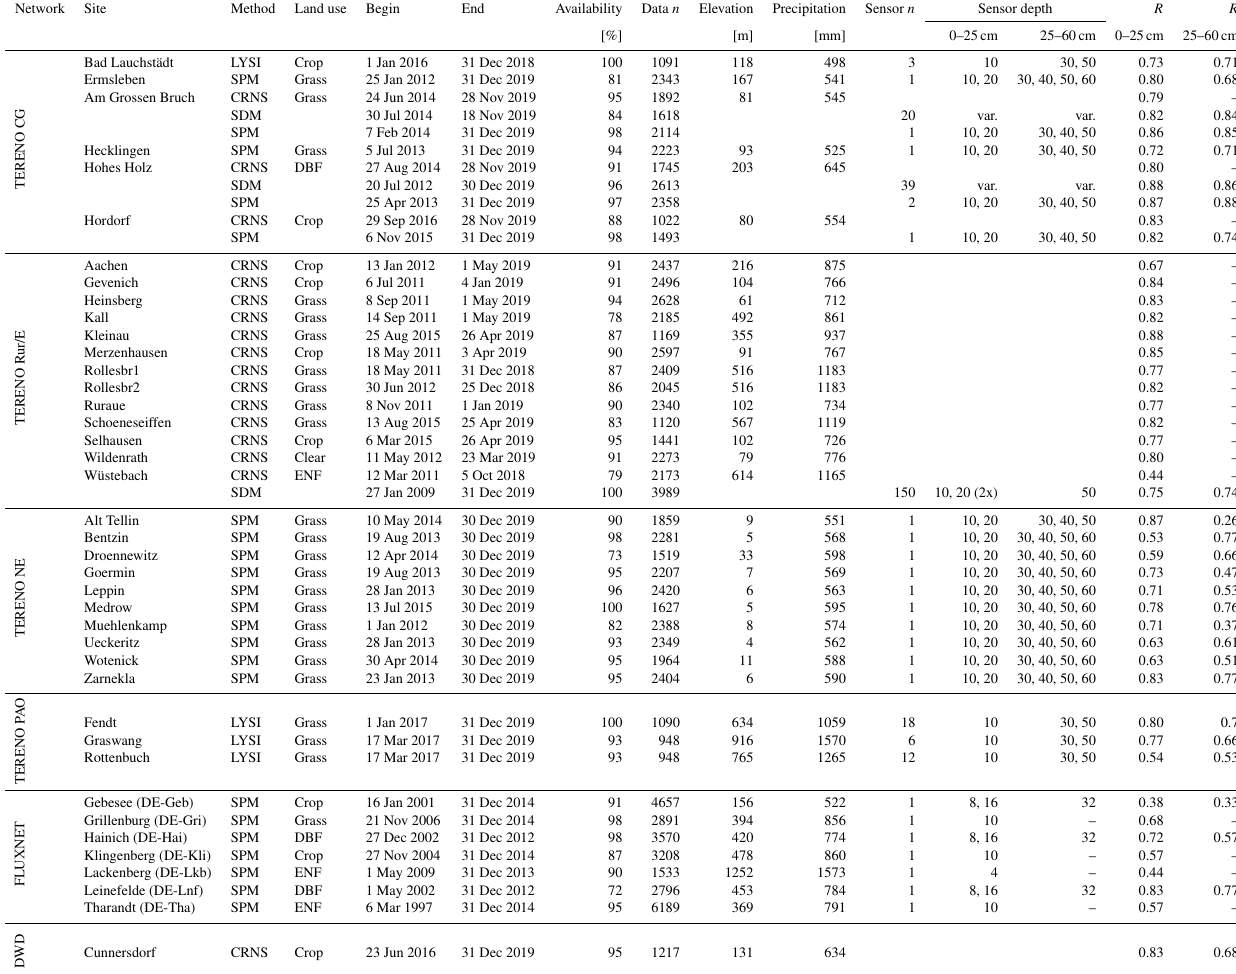
Table 2. Overview of SM measurement sites. Method denotes the different data sources: cosmic-ray neutron sensing (CRNS), spatially distributed measurements (SDM), single profile measurements (SPM), and lysimeter (LYSI). Network denotes the environmental observation network name (for TERENO: GC = Central Germany; Rur/E = Rur/Eifel; NE = Northeast; PAO = Pre Alpine Observatory), and Land Use describes the site characteristics (grass = grassland, crop = cropland, DBF = deciduous broadleaved forest, ENF = evergreen needled forest, clear = clearing). For FLUXNET, the original site name is included in parentheses. Sensor depths and numbers are denoted. R Spearman correlation coefficients of simulated versus observed deseasonalized SM anomalies in the GDM-v2-2021 setup shown are based on the whole period at 0–25 and 25–60cm